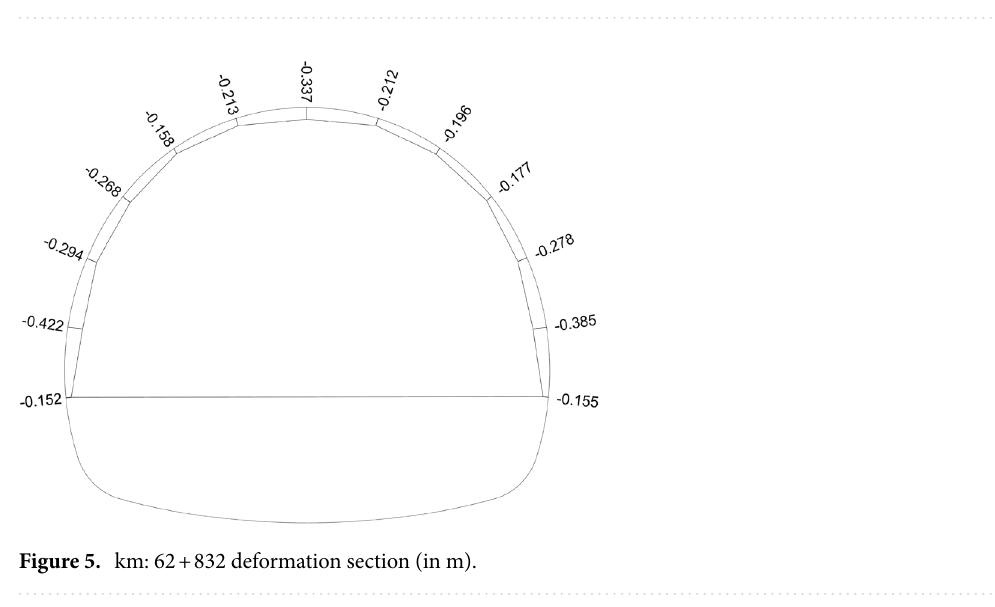
Figure 4. Deformation measurements were taken at km: 62 + 881.